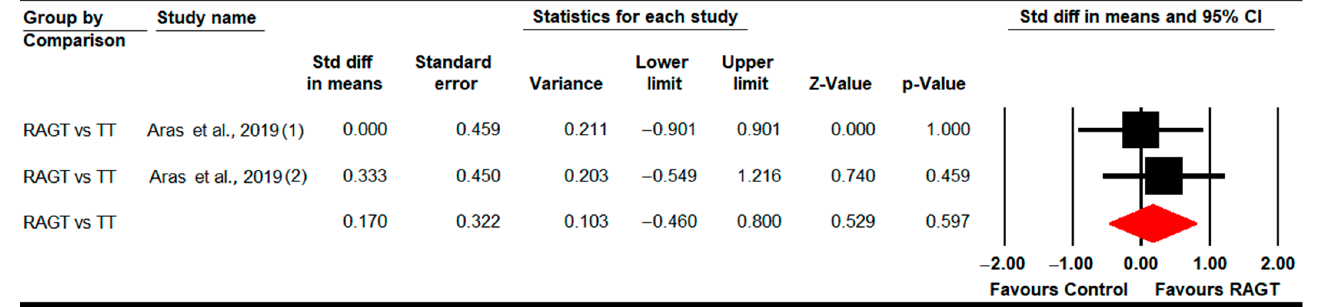
Figure 5. Forest Plot of Step width (Post-Intervention Assessment)